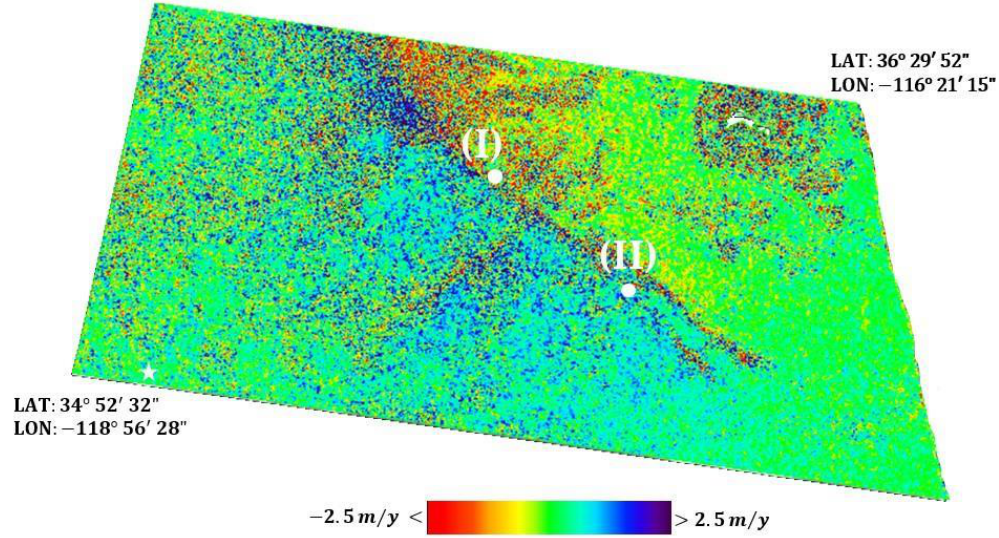
Figure 26. Geocoded mean displacement maps along the north–south direction of the Ridgecrest area, superimposed on an amplitude image. The labels (I) and (II) in white indicate two points across the fault where the north–south displacement time-series is estimated. All displacement measurements are evaluated with respect to a pixel, which is identified by a white star.